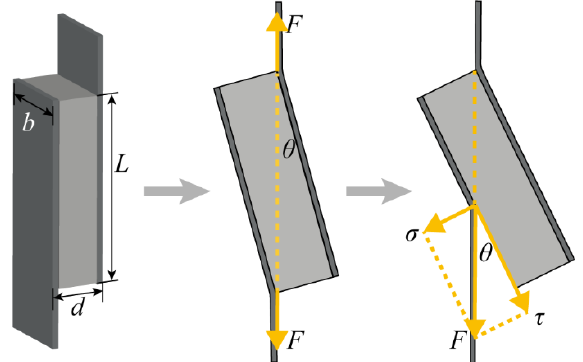
Figure 2. Diagram of interface peeling test.